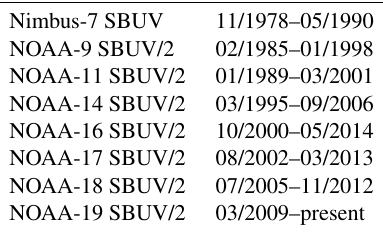
Table 2. SBUV satellite ozone data coverage used in this